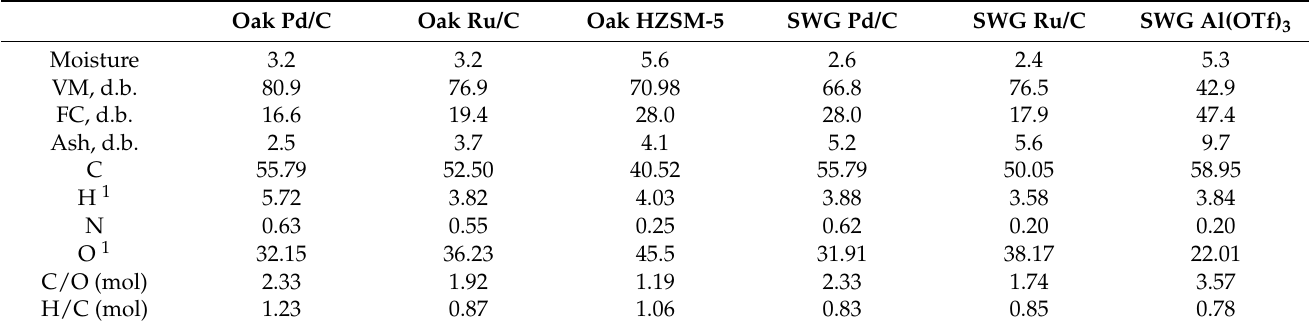
Table 4. Proximate and ultimate analysis (wt %) of cellulosic pulps isolated after lignin fractiona- tion/depolymerization in ethanol at 210 ◦ C using the biomass and catalyst combinations